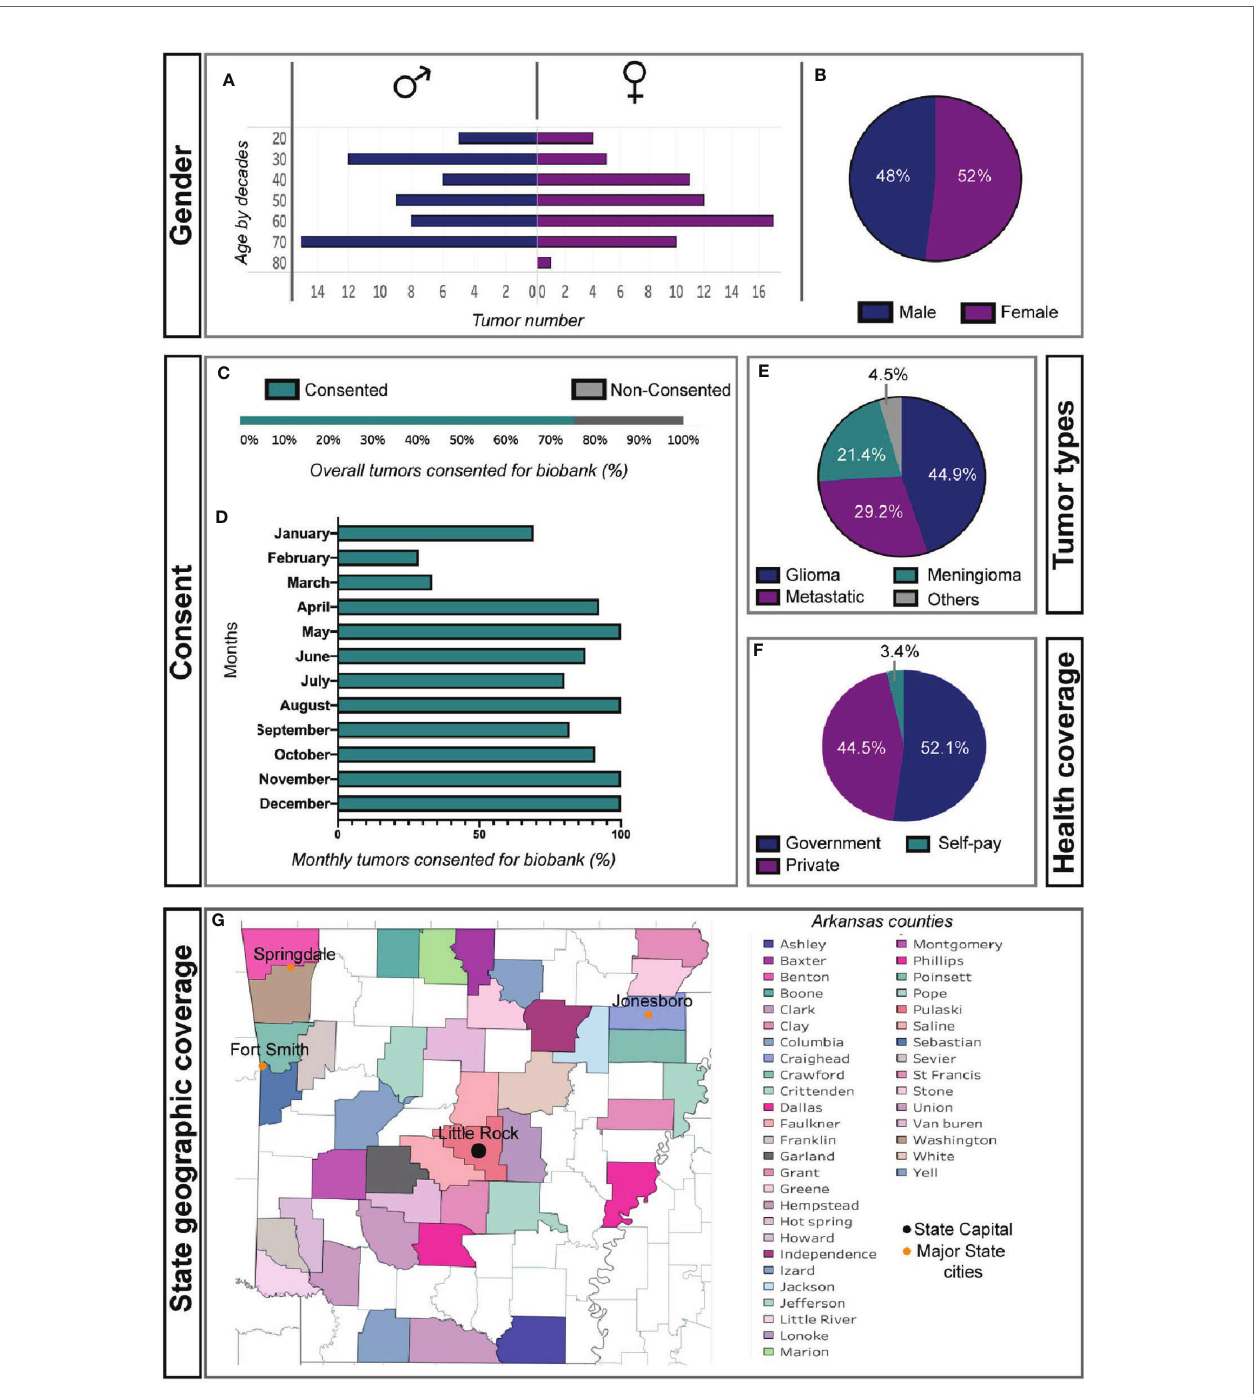
FIGURE 1 | Basic patient demographics from fi rst year of brain tumor biobank experience. (A) Gender and age by decade of cohort. (B) Percent of Male and Female patients consented (C) Overall and (D) monthly percent patients undergoing tumor resection consented for tumor biobank. (E) Diagnostic classi fi cation of biobanked tumors. (F) Insurance status of biobanked patients. (G) Regional distribution of patients among Arkansas